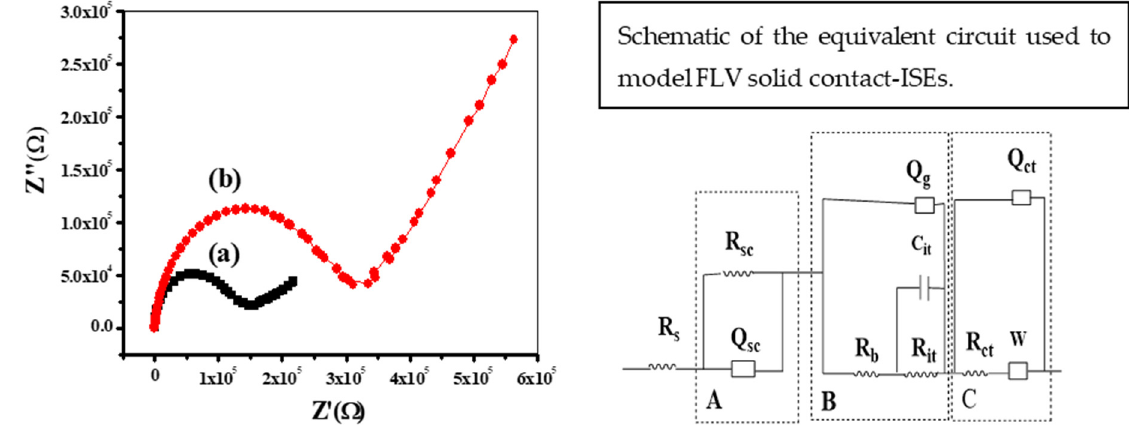
Figure 8. Electrochemical Impedance Spectroscopy (EIS) plots of the applied sensor ( a ) with and ( b ) without MWCNT as a solid contact material.